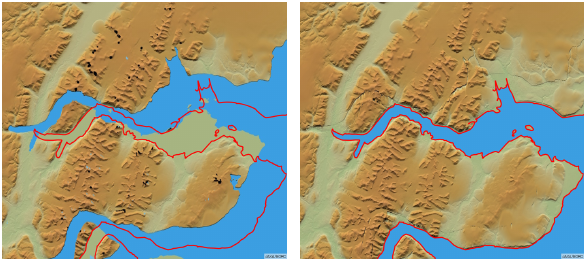
Figure 6. AW3D30 N80W016-021. Left: original, Right: sea masks corrected. Red lines and blue areas depict OSM coastlines and sea masks respectively.